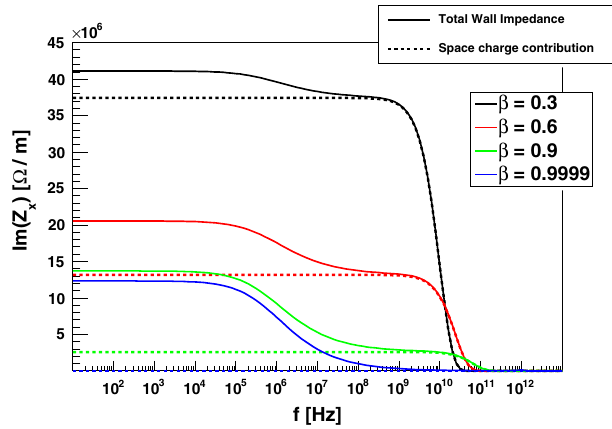
FIG. 18. (Color) Imaginary part of the transverse impedance for different values of (cid:9) . For nonrelativistic beams the coherent space-charge contribution